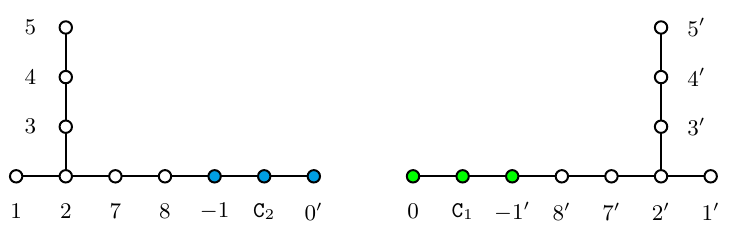
w 6 (cid:2) (cid:14) 0 , A 2 = (cid:14) 2 (cid:2) 1 w 0 and E = E 2 . 1 6 2 2